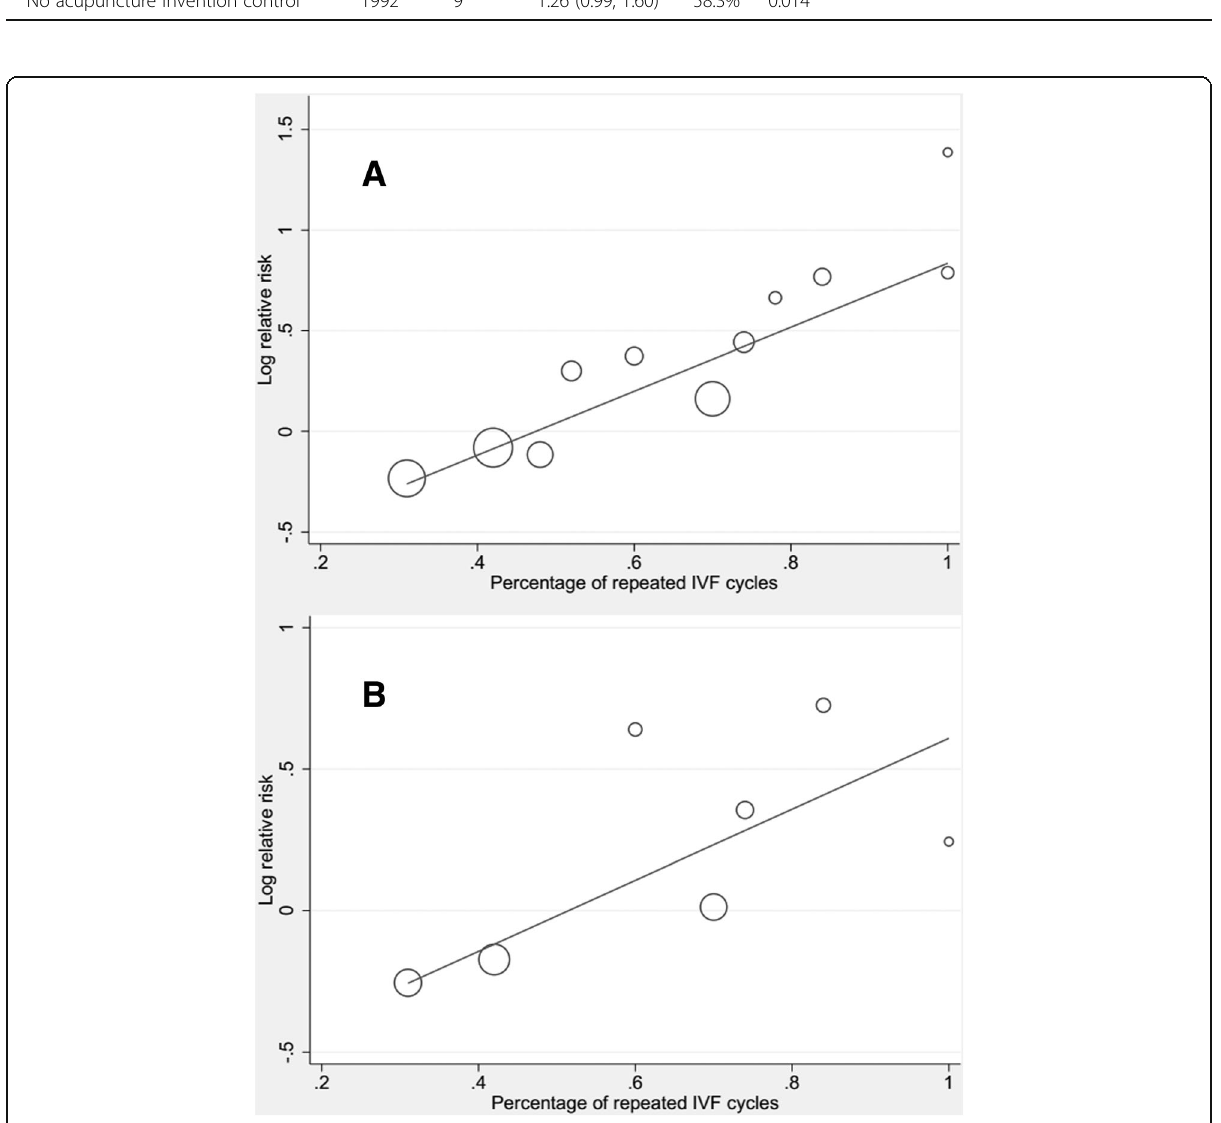
Fig. 4 Meta-regression between the effects of acupuncture on clinical pregnancy rates ( a )/ live birth rates ( b ) and repeated IVF cycle proportion as a single continuous